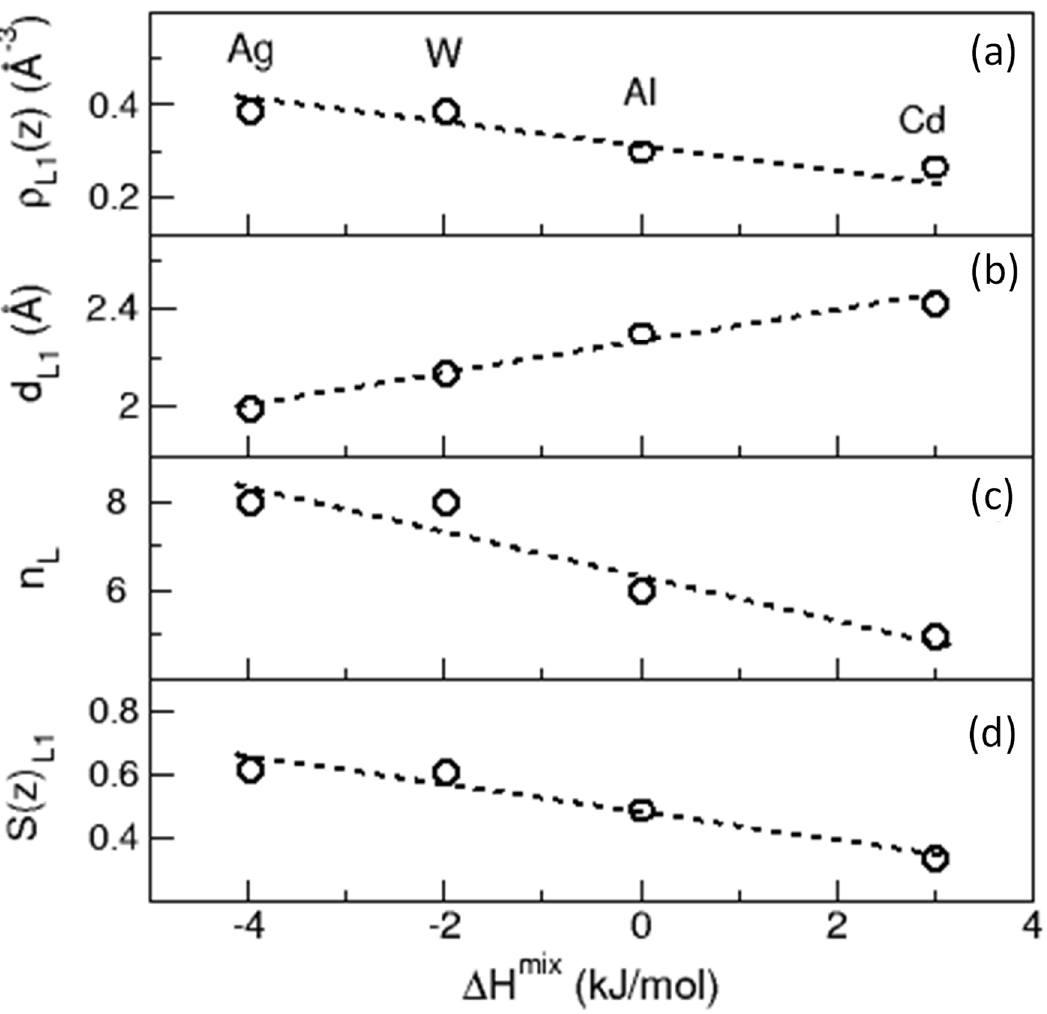
Figure 14. Chemistry effect on atomic ordering at the liquid/substrate interface [26]. ( a ) Peak density of L1, ρ L1 ( z ), ( b ) interlayer spacing of L1, d L1 , ( c ) number of interfacial layers, n L , and ( d ) in-plane atomic order parameter of L1, S ( z ) L1 , are plotted as a function of the heat of mixing, ∆ H mix , between the liquid Al and the substrate atoms for the systems of L-Al/S-Ag, L-Al/S-W, L-Al/S-Al, and L-Al/S- Cd, equilibrated at 1000 K. The atomic ordering in the liquid at the interface degrades monotonically with the transition from the attractive to repulsive interaction between the liquid and the substrate.